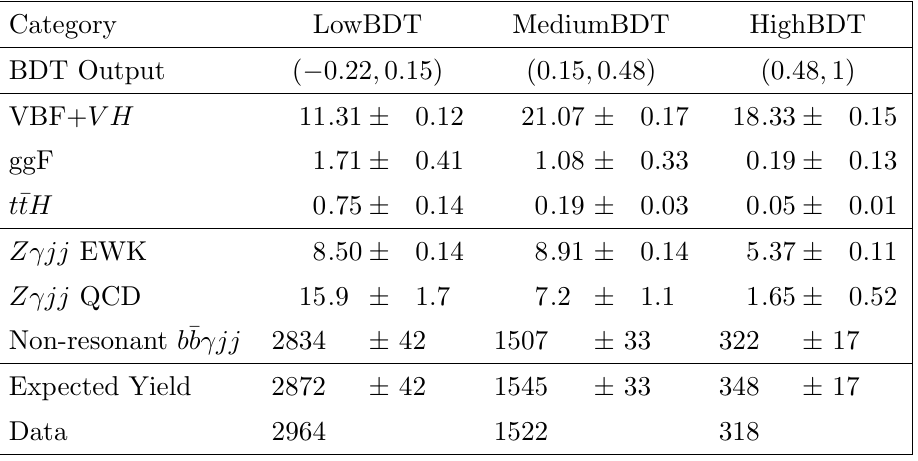
Table 2 . Data and expected yields for the Higgs boson signal, resonant Z(cid:13)jj and non-resonant b (cid:22) b(cid:13)jj background processes, in the three categories de(cid:12)ned by the BDT output discriminant. The event yields are calculated from simulated samples in the mass range 100 GeV < m bb < 140 GeV.